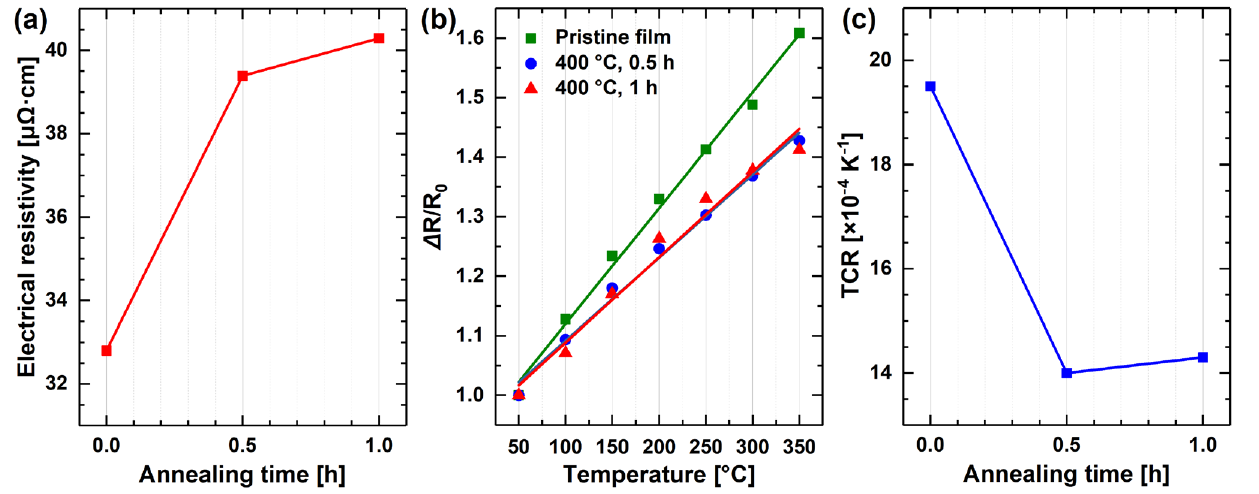
Figure 11. ( a ) Room-temperature electrical resistivity, ( b ) thermal resistance curves, and ( c ) TCR values of the WTi alloy film with 6.8 at.% Ti as a function of vacuum-annealing time. The repeatability of the 6.8 at.% Ti alloy film after annealing for 30 min was charac- terized, as shown in Figure 12. After annealing, the thermal resistance of the alloy film tends to be stable several times. Except for the first time, the thermal resistance curves of the other four times basically coincided, and the TCR also tended to be stable. The results show that, after annealing for 30 min, the structure of the 6.8 at.% Ti alloy film does not change and the thermal resistance remains stable.